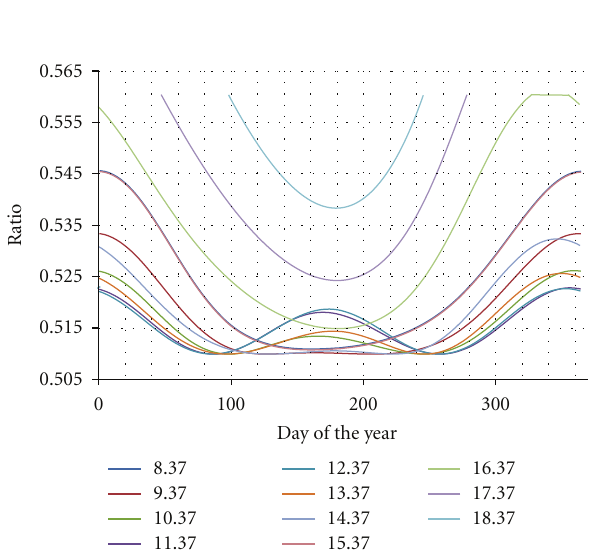
Figure 6: Case 3 configuration.